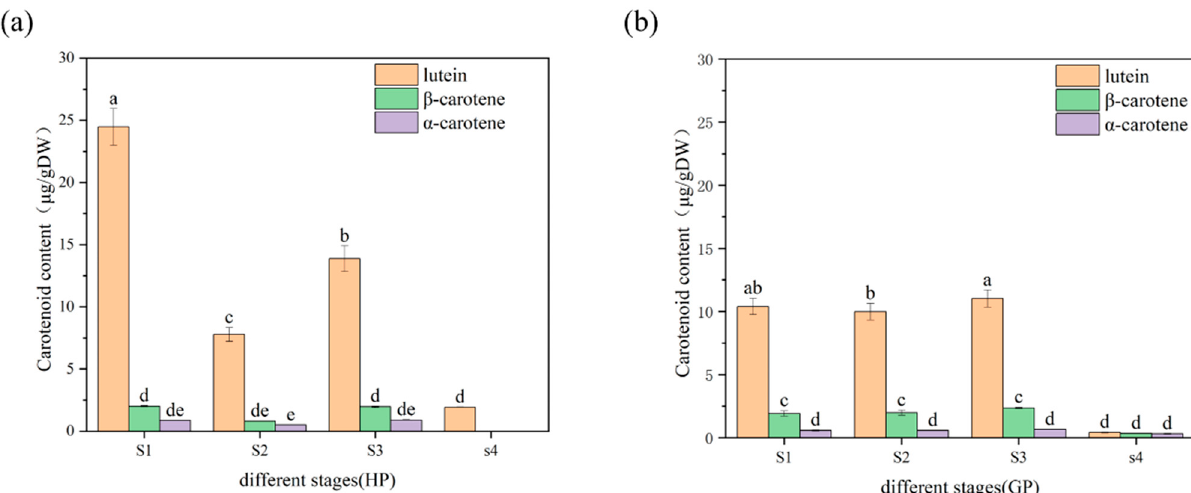
Figure 2. Changes in carotenoids content and compositions in pomelo young fruit. ( a ) Changes in carotenoids content and composition of honey pomelo during four developmental stages; ( b ) Changes in carotenoids content and composition of golden pomelo during four developmental stages. Different letters indicate significant differences between values ( p < 0.05).